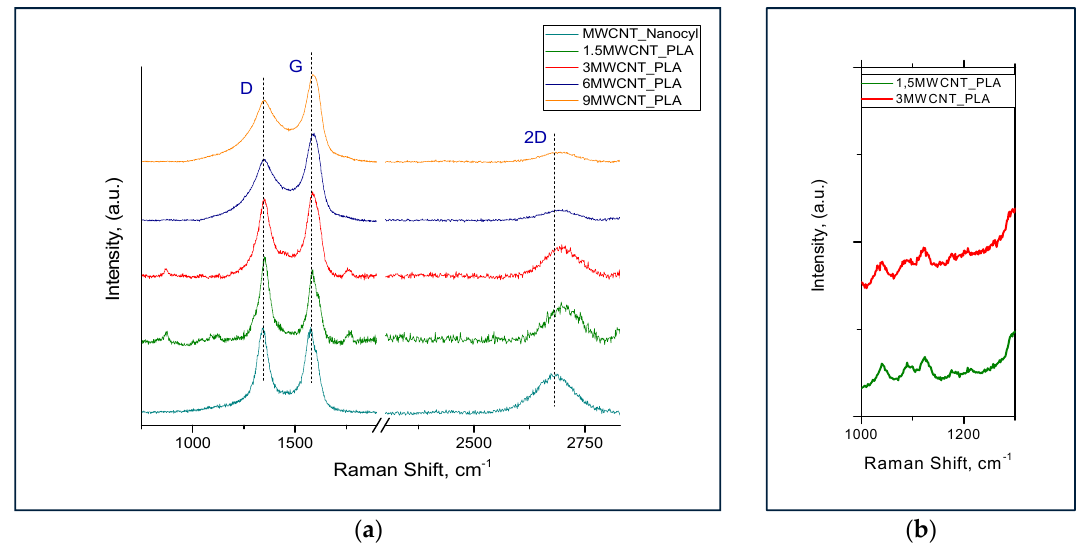
Figure 3. Normalized Raman spectra of nanocomposites with rising MWCNTs concentration and pristine nanotubes as a reference ( a ), enlargement between 1000 and 1500 cm − 1 ( b ).